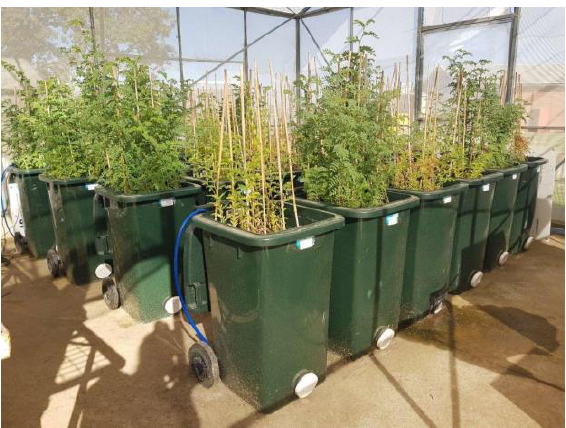
Figure 1. Wheelie bins with volume 100 L used as deep pots in Experiment 1 to investigate the effects of waterlogging and P. medicaganis infection on eight chickpea genotypes. of waterlogging and P. medicaganis infection on eight chickpea